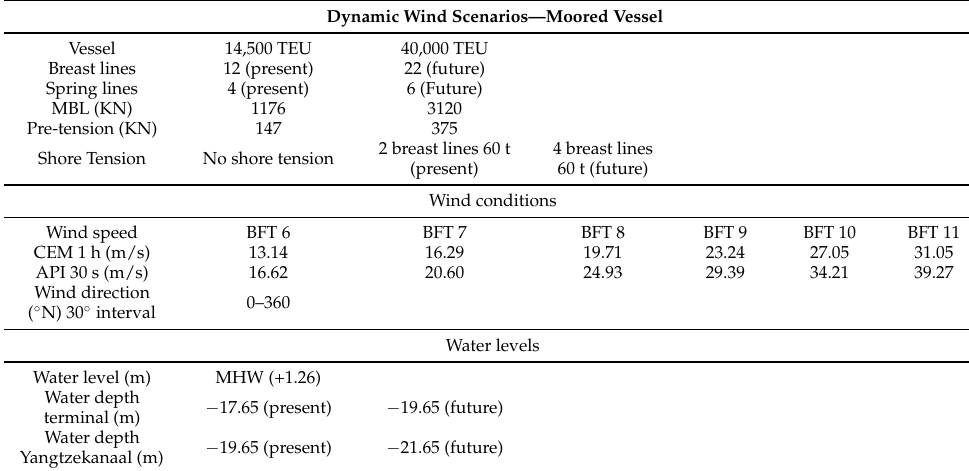
Table 3. Test program for dynamic wind conditions.